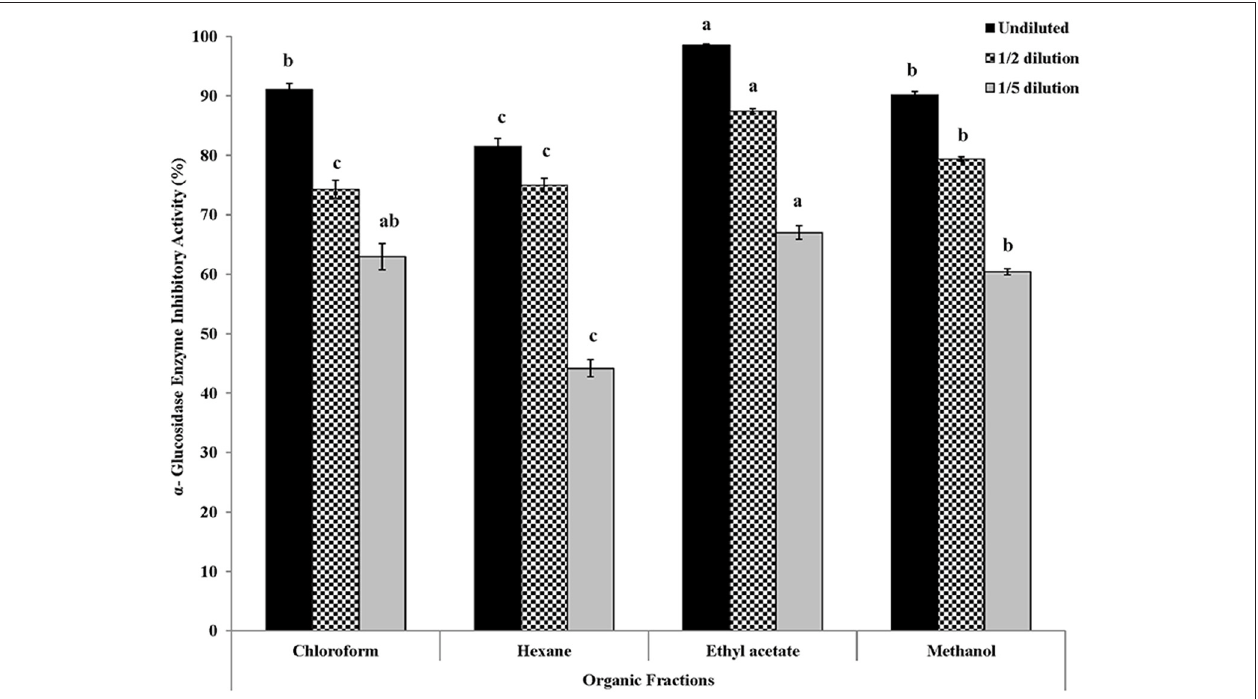
FIGURE 6 | α -Glucosidase enzyme inhibitory activity (% inhibition) of undiluted, half-diluted, and one-fifth diluted samples of four organic solvent extracted fractions of red dried calyces of Roselle. Different lower-case letters represent statistically significant differences in α -glucosidase enzyme inhibitory activity between different organic solvent extracted fractions at 95% confidence level (Tukey’s